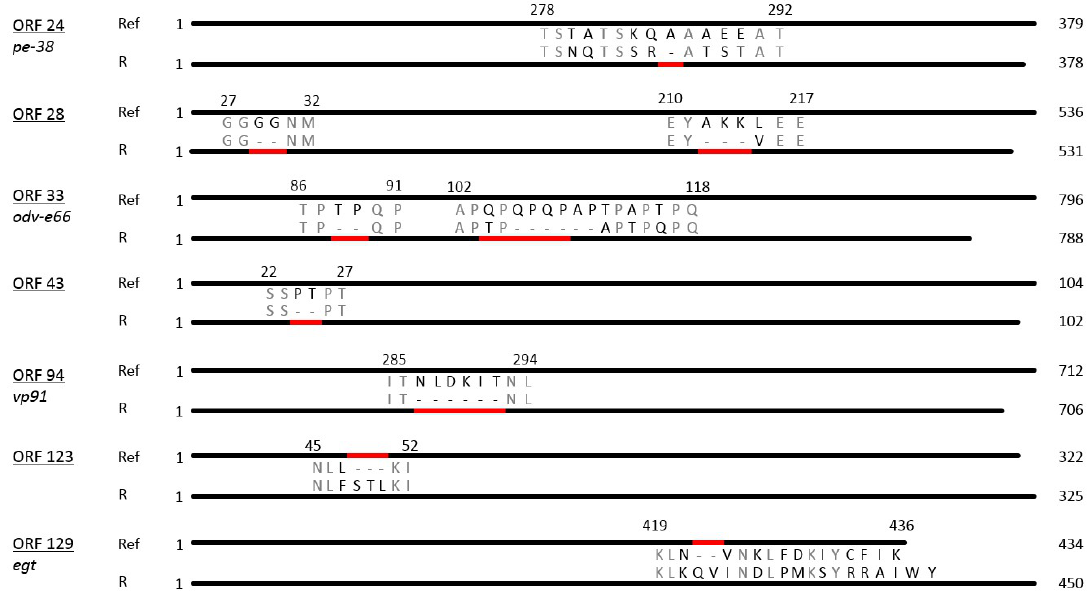
Figure 2. Diagrammatic representation of amino acid sequences representing ORFs with indels in PhopGV-R aligned with the respective ORFs from the reference isolate NC004062. The total amino acid length of each ORF is shown to the right, while the numbers above each insertion/deletion region represent the corresponding amino acids from the aligned reference sequence. Deletions/insertions are indicated by a red bar.